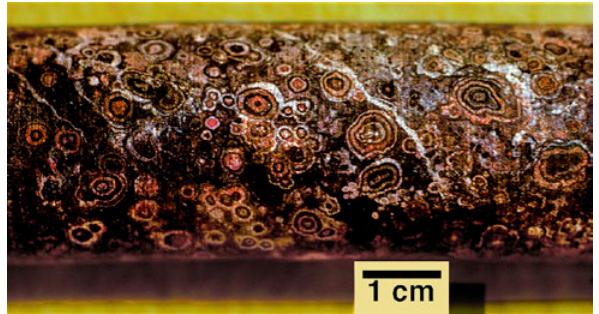
Figure 58. Orbicular quartz-magnetite from drill core through the lower part of the Peko diapiric ore pipe, Tennant Creek. The oolitic texture indicates that precipitation of precursor lepidocrocite and polymeric silica round synerectic nuclei is a sol-gel transition rather than a chemical reaction or from supersaturated solution. Clearer quartz veins which cut the oolites reflect the soft particulate nature of the precursors.